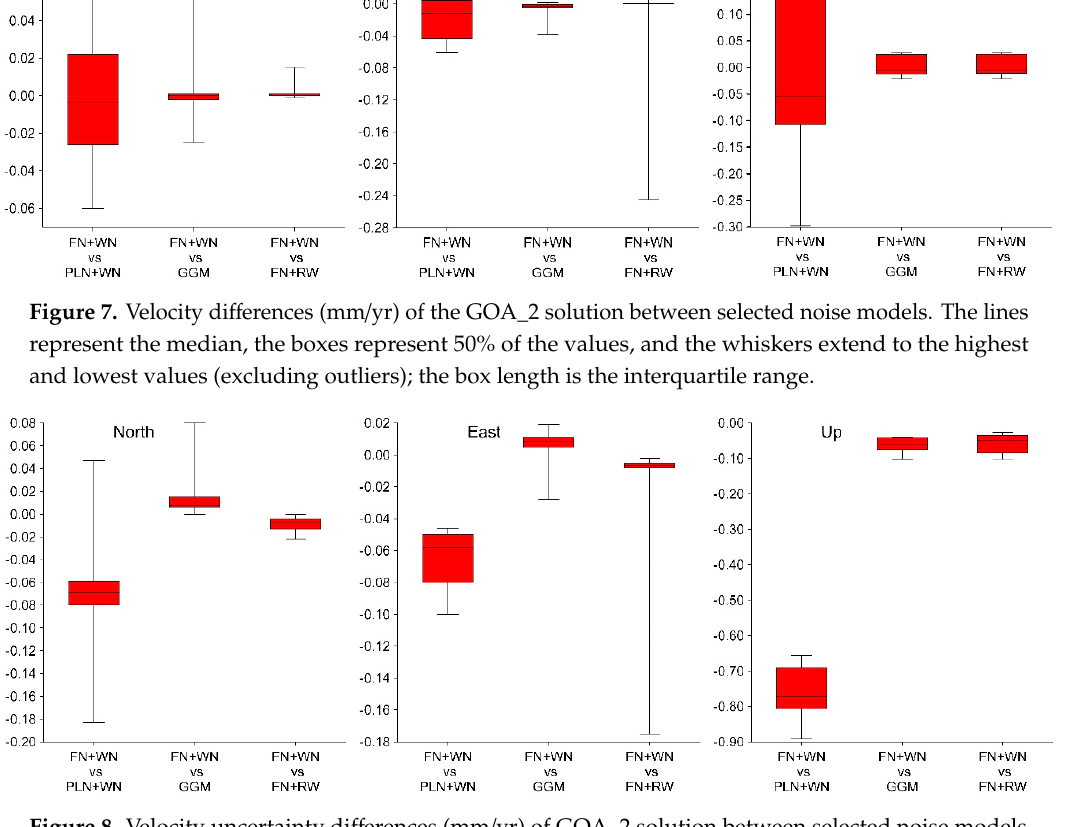
Figure 8. Velocity uncertainty differences (mm/yr) of GOA_2 solution between selected noise models. The lines represent the median, the boxes represent 50% of the values, and the whiskers extend to the highest and lowest values (excluding outliers); the box length is the interquartile range. Table 5. The mean and standard deviation in mm / yr of the Up velocity residuals from di ff erent LU and GIA models based on the solution All compared solutions showed also similar differences from LU and GIA models. The Hector solution with the IQ-factor 2.2 (solution GOA_2) demonstrated slightly better overall performance.